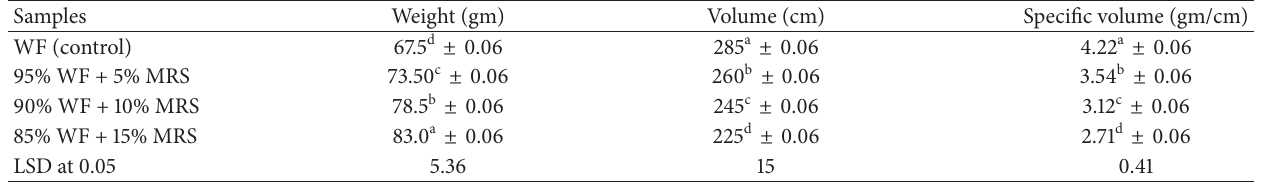
Table 6: Baking quality of Fino bread as affected by the addition of MRS.